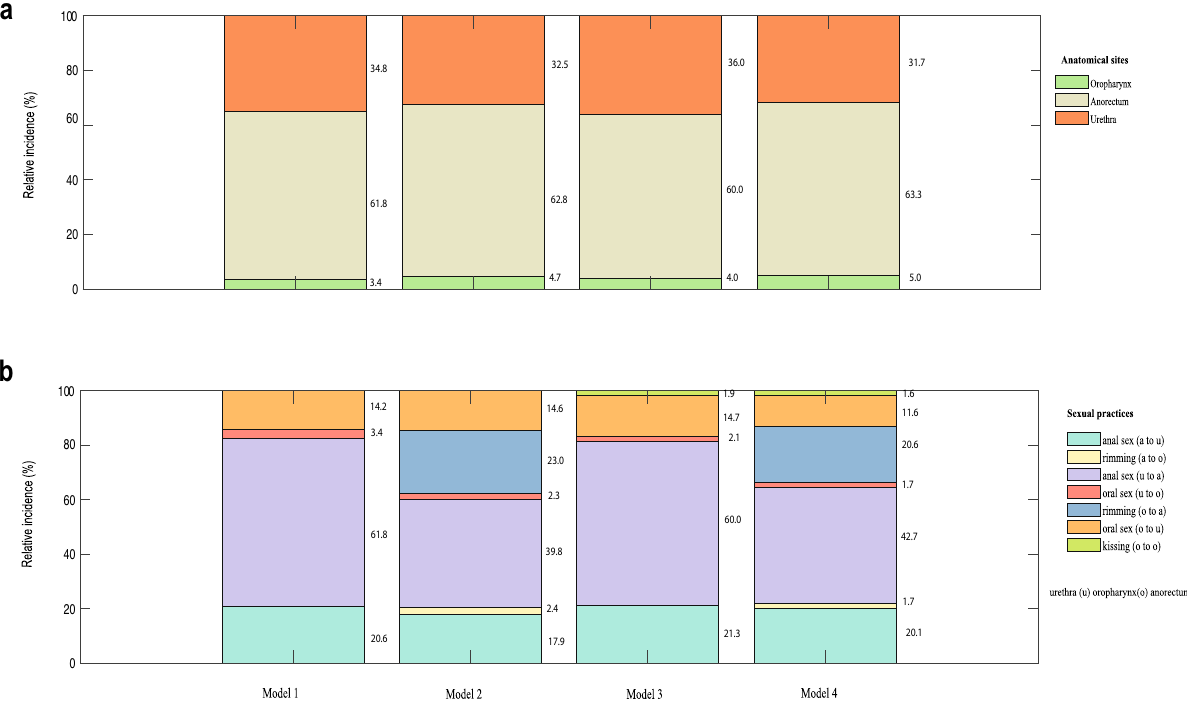
Figure 2. The estimated relative incidence of Mycoplasma genitalium . ( a ) The estimated relative incidence at the oropharynx, anorectum or urethra in MSM from the four models (%). Model 1: Only oral sex and anal sex transmit Mycoplasma genitalium ; Model 2: Only oral sex, anal sex and rimming transmit Mycoplasma genitalium ; Model 3: Only oral sex, anal sex and kissing transmit Mycoplasma genitalium ; Model 4: Oral sex, anal sex, rimming, and kissing transmit Mycoplasma genitalium . ( b ) The estimated relative incidence caused by sexual practices in MSM from the four models (%). Model 1: Only oral sex and anal sex transmit Mycoplasma genitalium ; Model 2: Only oral sex, anal sex and rimming transmit Mycoplasma genitalium ; Model 3: Only oral sex, anal sex and kissing transmit Mycoplasma genitalium ; Model 4: Oral sex, anal sex, rimming, and kissing transmit Mycoplasma genitalium